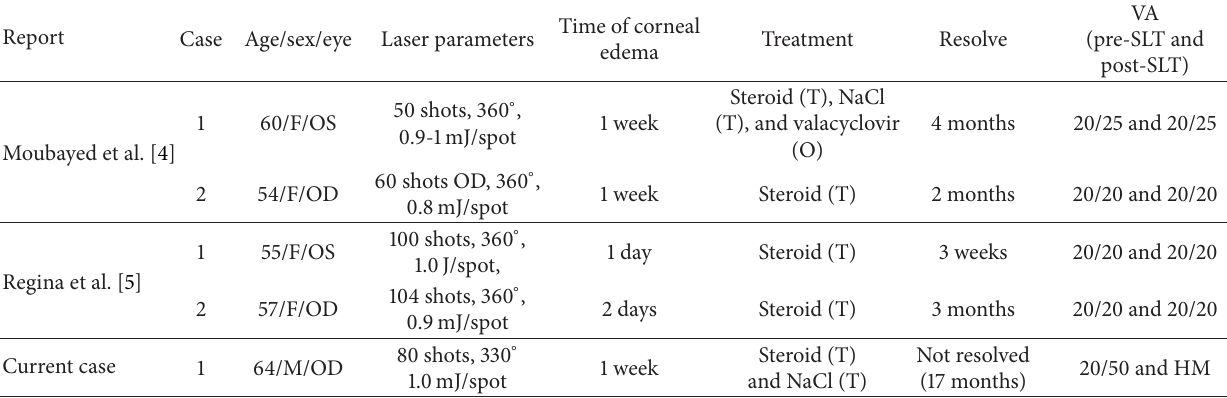
Table 1: Features of previously reported cases and the current case.